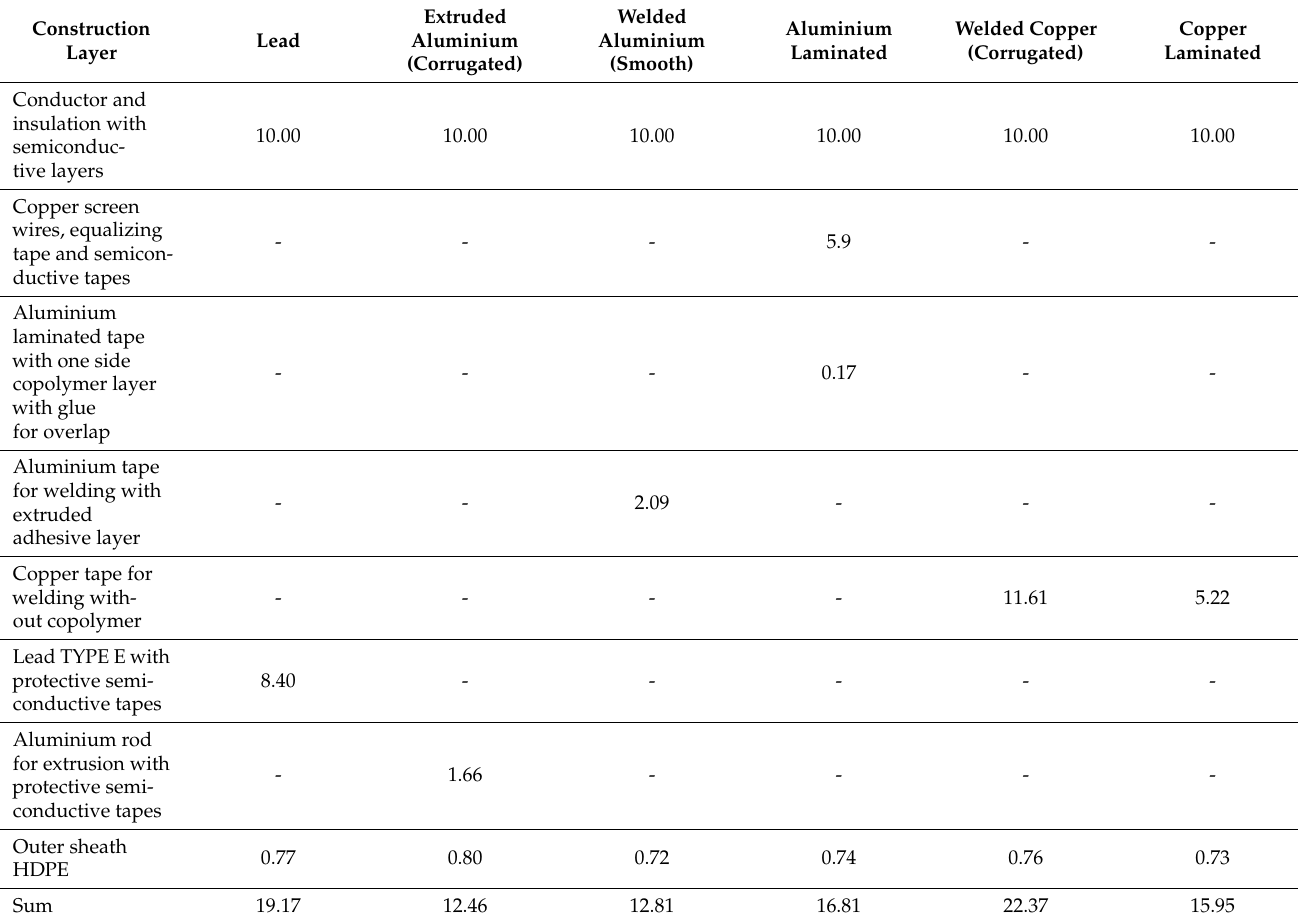
Table 3. Single-core costs comparison for the different radial water barrier